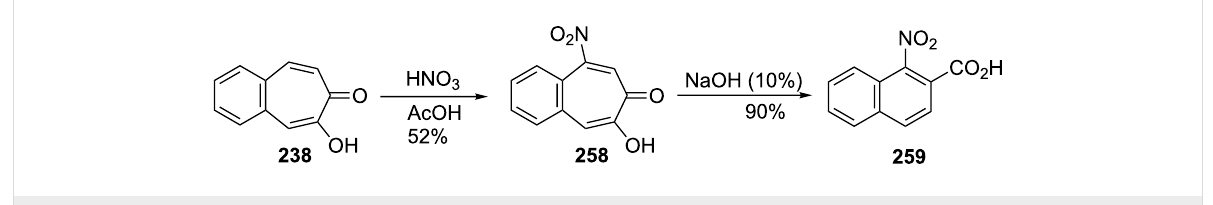
Scheme 40: Nitration product of 4,5-benzotropolone ( 238 ) and its isomerization to 1-nitro-naphthoic acid ( 259